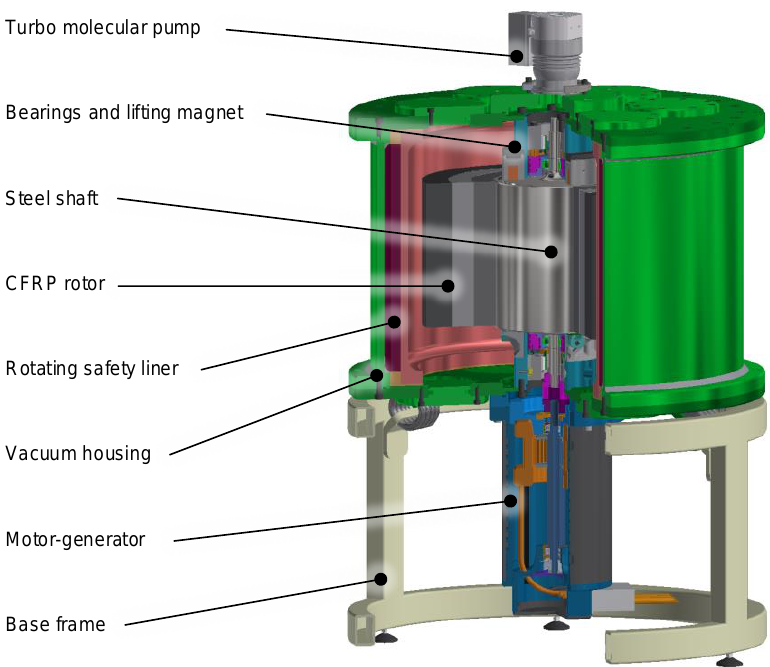
Figure 2. CAD model of the FlyGrid FESS in a 5 kWh, 100 kW configuration.